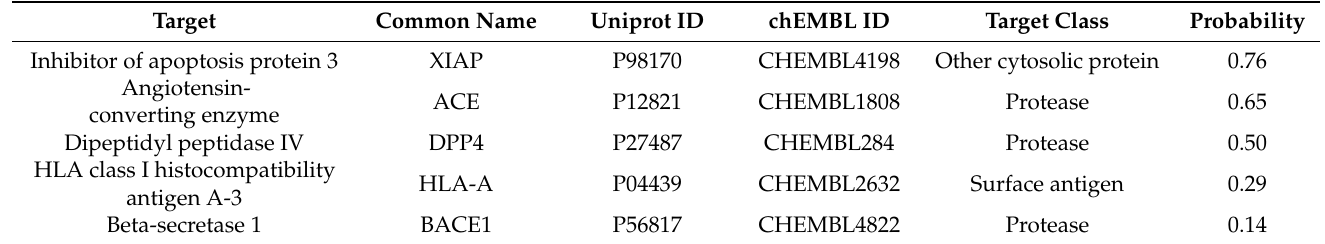
Table 3. List of top five potential molecular targets of HTDT-6-2-3-2 as predicted by